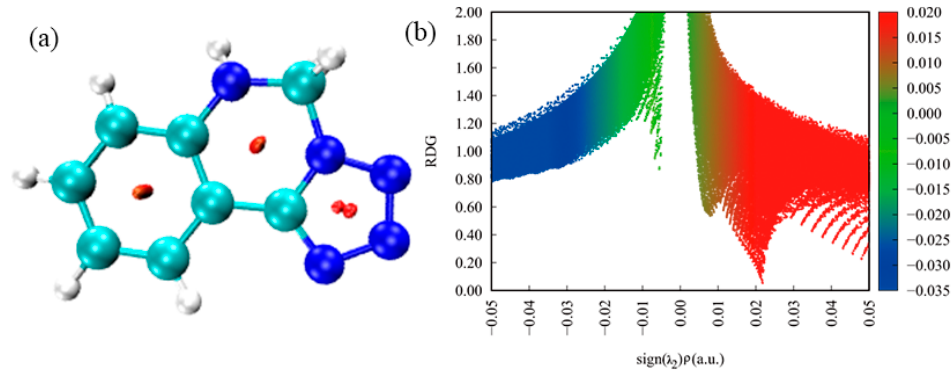
Figure 8. RDG map and NCI plot of gradient isosurface of Crystal a : ( a ) noncovalent interactions analyses; ( b ) scatter graph.